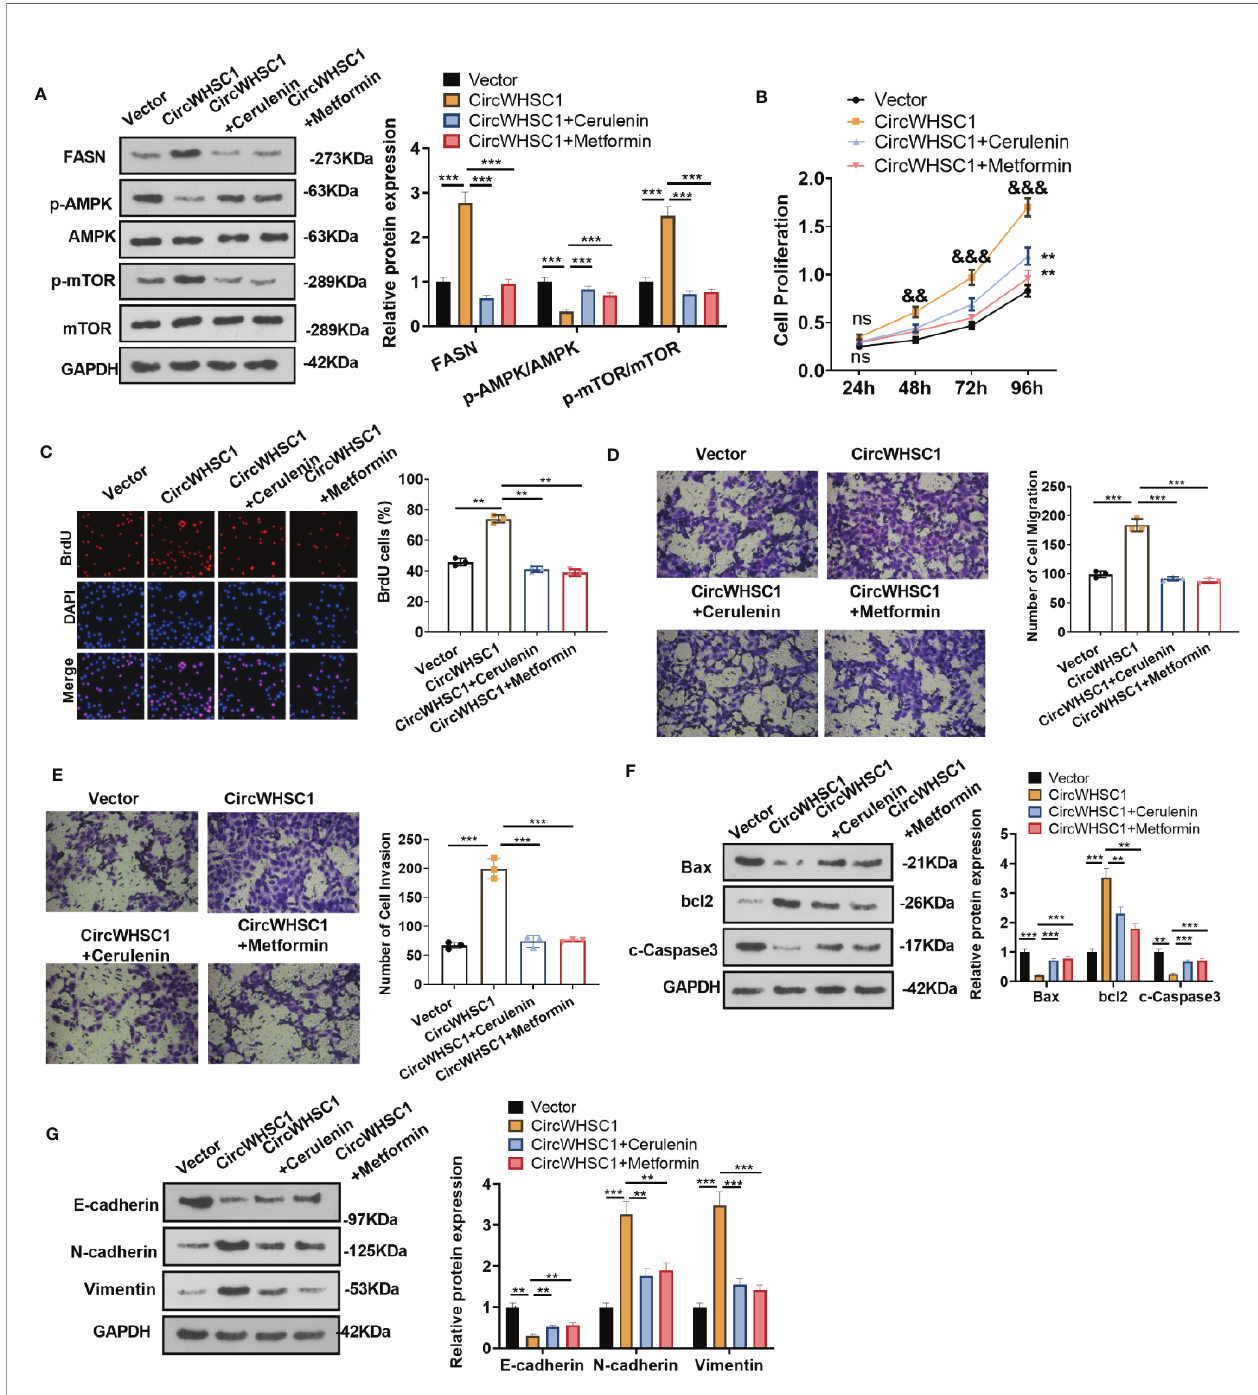
FIGURE 8 | Inhibiting FASN or activating the AMPK pathway reversed circWHSC1-mediated oncogenic effects on BC cells. MCF7 cells were transfected with the negative vector or circWHSC1 overexpression plasmids and then treated with the FASN inhibitor Cerulenin (2mg/L) or the AMPK activator Metformin (20 mM). (A) WB tested FASN, AMPK and mTOR levels. (B) CCK-8 tested cell viability. ns P > 0.05, ** P < 0.01 (vs.vector group), && P < 0.01, &&& P < 0.001 (vs. circWHSC1 group). (C) . BrdU staining evaluated cell proliferation. (D, E) Cell migration and invasion were tested by the Transwell assay. (F, G) WB assessed the expressions of Bax, bcl2, and c-Caspase3 and EMT-related proteins E-cadherin, N-cadherin and Vimentin. ** P < 0.01, *** P < 0.001.